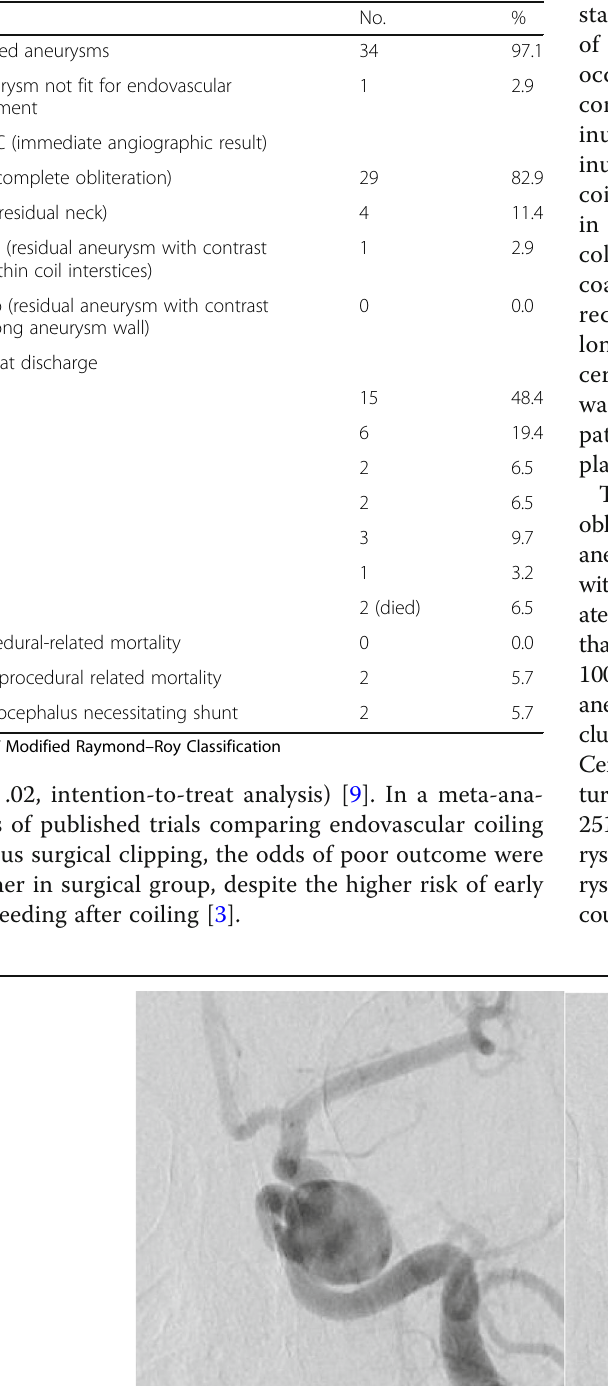
Table 3 Procedural